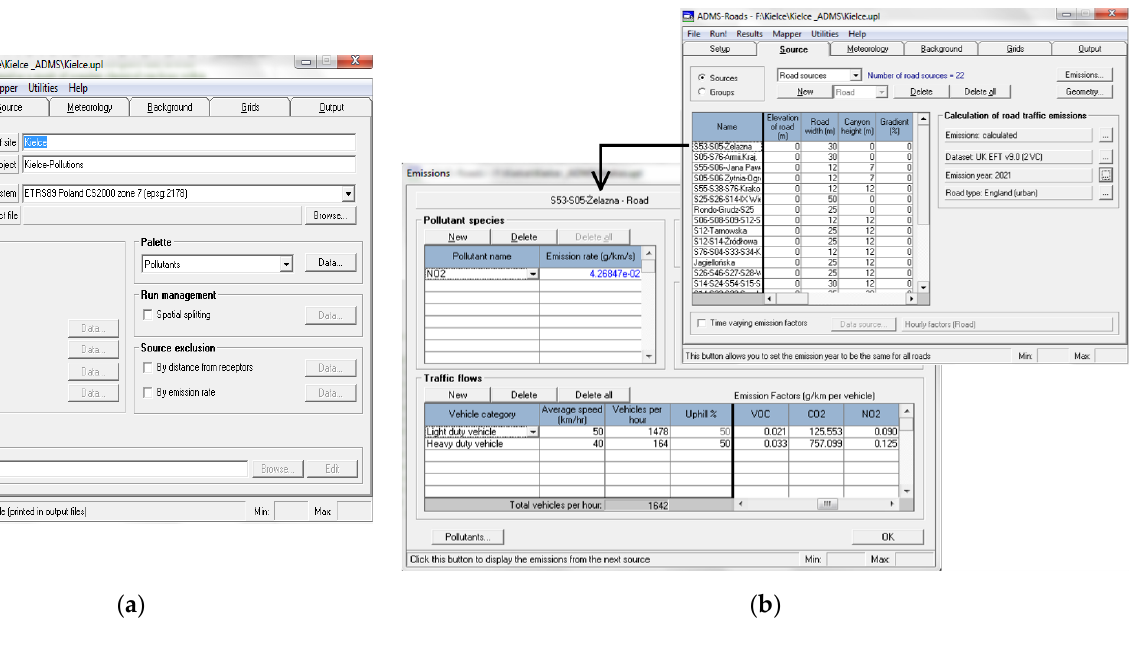
Figure 3. ( a ) Setup of an ADMS-Roads dialogue box without model options; ( b ) ADMS-Roads Emissions dialogue box.